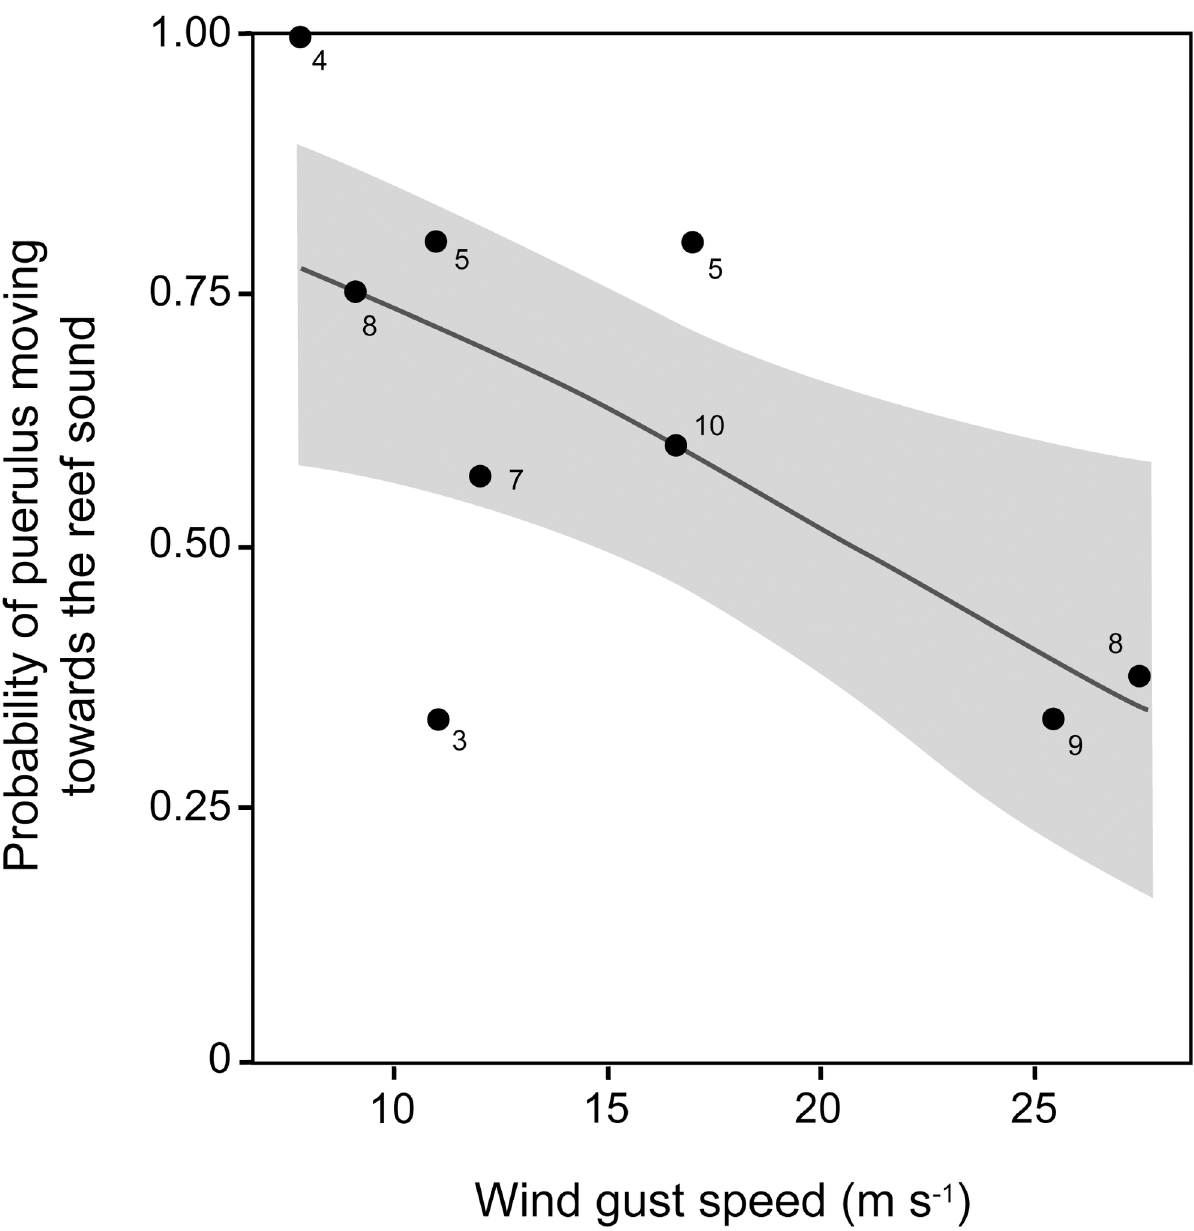
Fig 4. Predicted probability and observed proportion of puerulus choosing to move towards the reef sound for the range of wind gust speeds experienced over the study period. Predicted probability of a Jasus edwardsii puerulus choosing to move towards the reef sound moderated by the wind gust speed (m s -1 ), based on a logistic regression (grey area represents the 90% CI) (Wald Z = -2.4; P = 0.02; n = 59). Black dots in the graph represent the observed proportion of the puerulus per night choosing to move towards the reef sound, while the numbers adjacent to the black dots represents the total puerulus sample size used to generate the proportion.